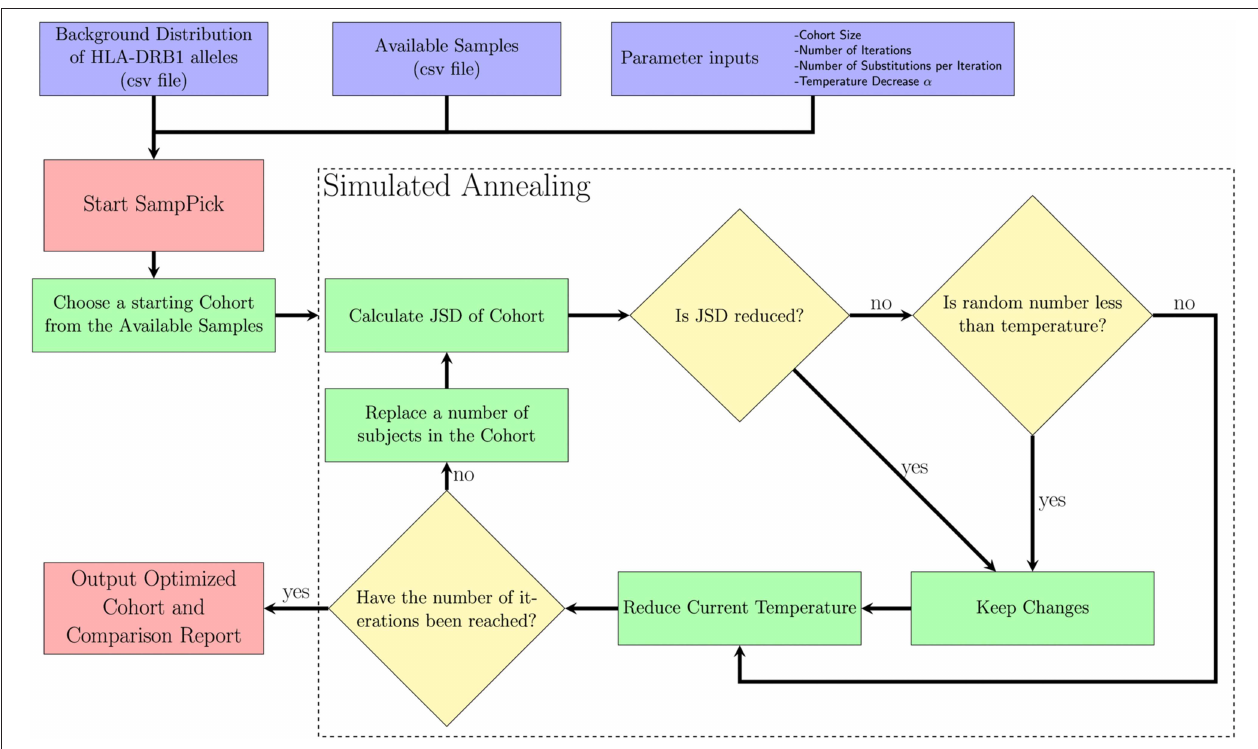
FIGURE 1 | A description of the SampPick algorithm. The user inputs a background distribution, a set of available samples and/or a sample to test, and parameters for the algorithm. The algorithm will proceed for the prescribed number of iterations, making substitutions to the samples chosen in order to obtain the sample closest to the background distribution ranked by Jensen-Shannon